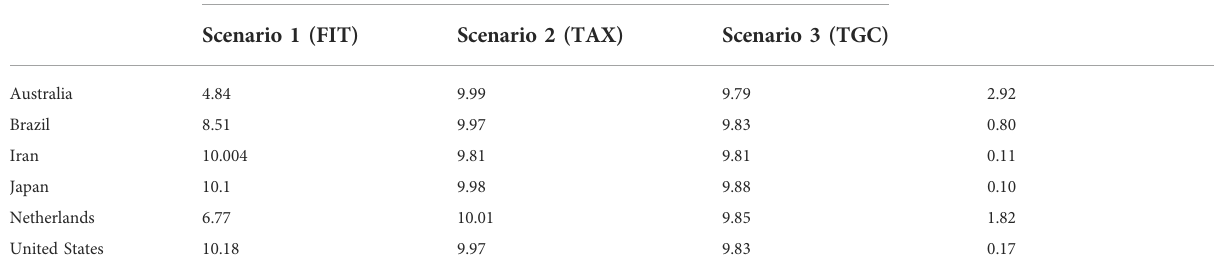
TABLE 7 No. of exited members from InCESs. Country The average maximum number of members who exit a community